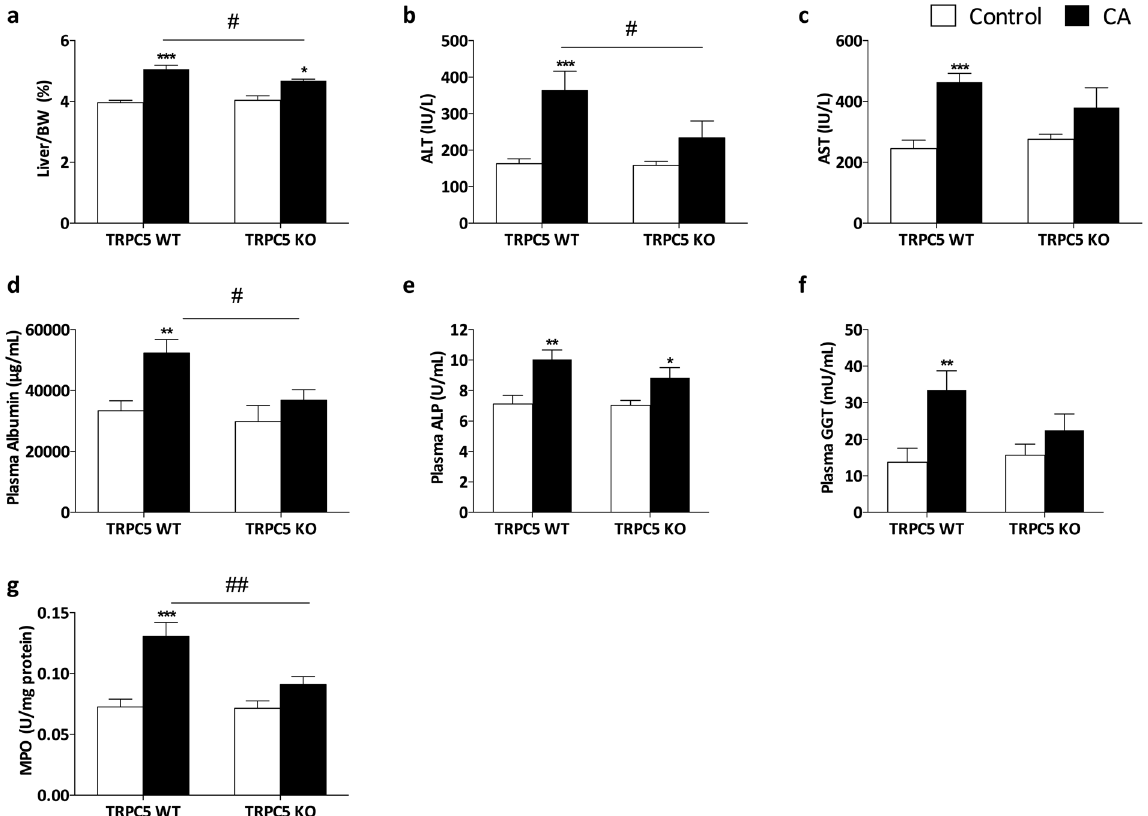
in WT and TRPC5 KO mice. Liver injury was assessed by measuring plasma ALT ( b ), AST ( c , d ) albumin, ( e ) ALP, and ( f ) GGT. ( g ) Hepatic myeloperoxidase (MPO) activity following CA-induced cholestasis in WT and TRPC5 KO mice. Results are mean ± S.E.M., n = 6–7. * P < 0.05, *** P < 0.001 vs control; # P < 0.05 vs WT CA as determined by two-way ANOVA and Bonferronni Post Hoc